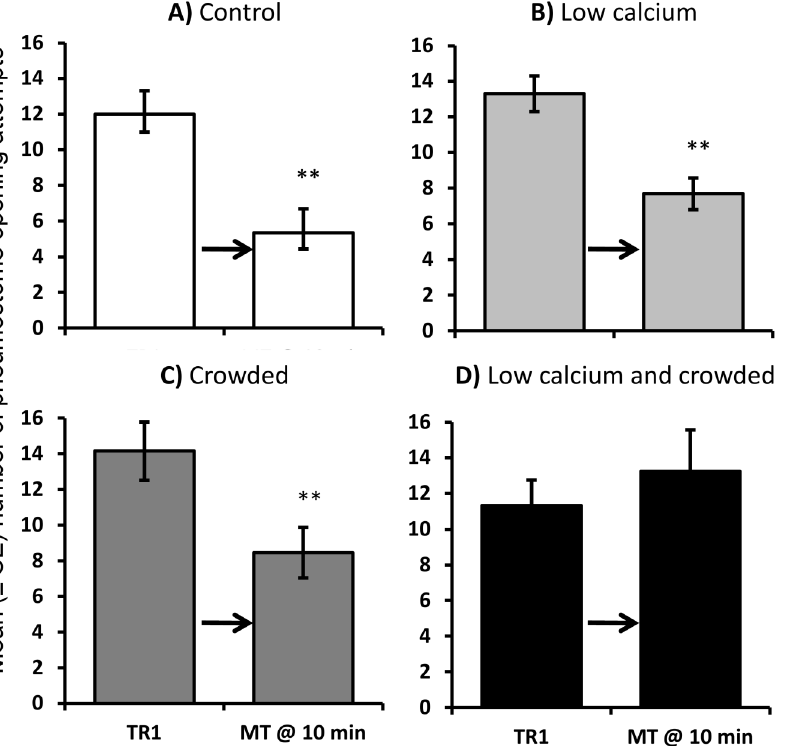
Figure 3. Behavioural assessment of short-term memory (STM). Mean ( 6 SEM) number of pneumostome opening attempts during training (TR1) and the test for short-term memory 10 min following training (MT @ 10 min). Lymnaea were exposed to: A) control conditions (white bars; N=12); B) low calcium availability (pale grey bars; N=13); C) crowding (dark grey bars; N=13) or D) a combination of low calcium availability and crowded conditions (black bars; N=12). ** = significant difference between training and the memory test (P , 0.01, paired